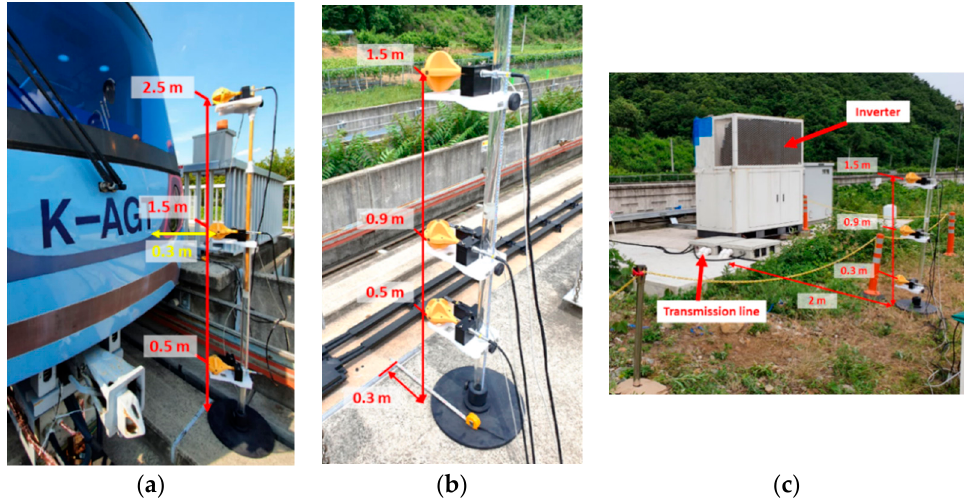
Figure 9. EMF measurement points: ( a ) outside the rolling stock, ( b ) platform, ( c ) near the inverter. Table 4. Magnetic fields measured outside the rolling stock and surrounding infrastructure.